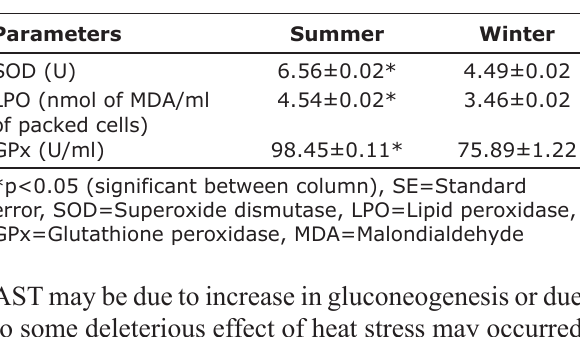
Table-4: Oxidative stress parameters (mean±SE) during summer and winter